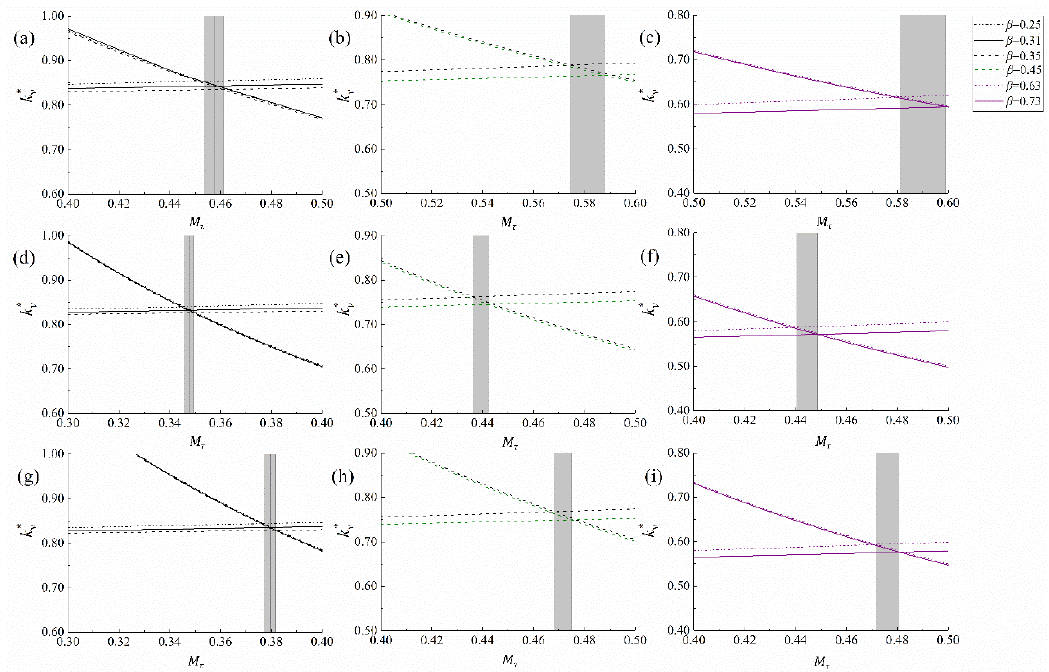
Figure 6. M 0 changed with the cosine of the leaf angle ( β ). In this study, the observed β of broadleaf forest ranged from 0.25 to 0.35 with an original value of 0.31 in the model; the observed β of scrub ranged from 0.35 to 0.45 with an original value of 0.45, and the observed β of steppe ranged from 0.63 to 0.73 with an original value of 0.73. The intersection of the auxiliary vertical line and abscissa is M 0 . Vegetation types and soil texture types: ( a , d , g ) Broadleaf forest; ( b , e , h ) scrub; ( c , f , i ) steppe; ( a – c ) sandy loam; ( d – f ) loam; ( g – i ) loamy clay, clay loam, or sandy clay